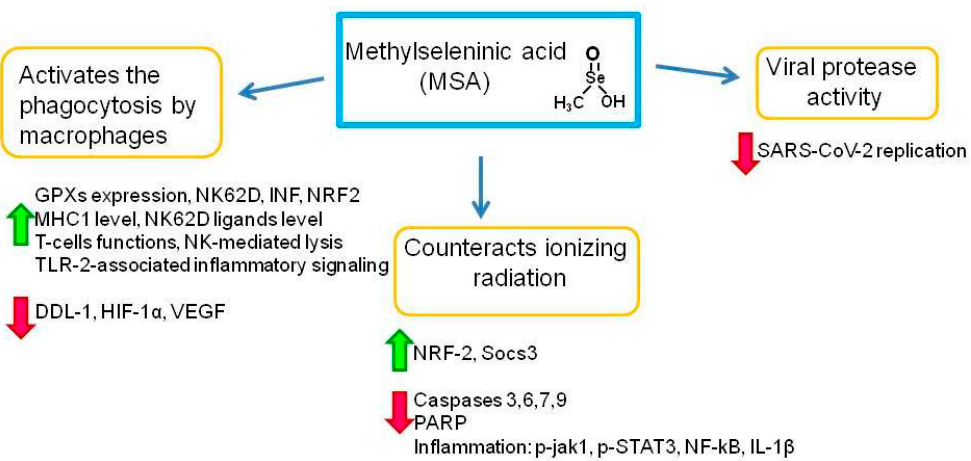
Figure 3. Role of methylseleninic acid in the regulation of the immune system and cytoprotections. GPX—glutathione peroxidases; NK62D—transcription factor; INF—interferon; NRF2—nuclear factor erythroid 2–related factor 2; MHC1—major histocompatibility complex (class I); TLR-2—toll-like receptor 2; DDL-1—DDHD domain-containing lipase 1; HIF-1 α —hypoxia-inducible factor 1-alpha; VEGF—vascular endothelial growth factor; Socs3—suppressor of cytokine signaling 3; PARP—poly (ADP-ribose) polymerase; p-jak1—phosphorylated janus kinase 1; p-STAT3—phosphorylated signal transducer and activator of transcription 3; NF- κ B—nuclear factor kappa-light-chain-enhancer of activated B cells; IL-1 β —interleukin-1 beta. Expression enhancement is indicated by green arrows and suppression by red